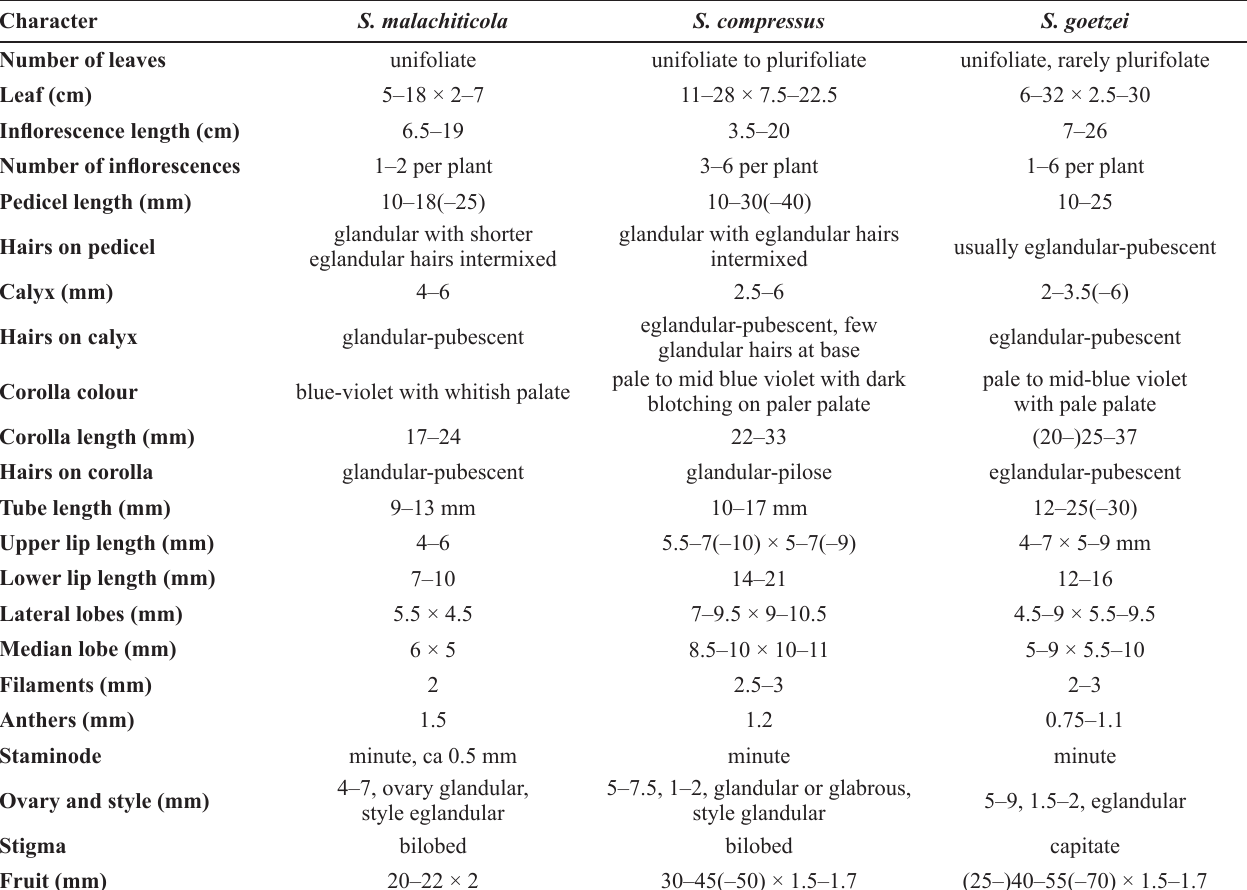
Table 1 – Comparison of the key characters for Streptocarpus malachiticola and its